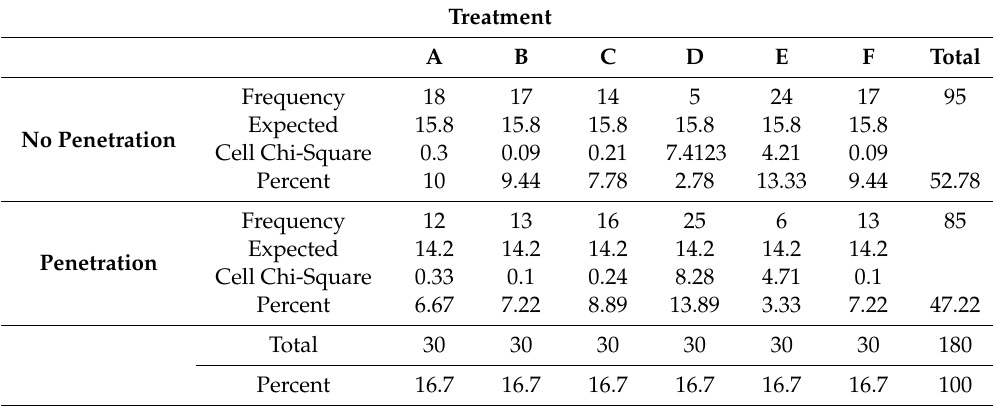
Table 2. Penetration of the dye beneath the dental sealant showing di ff erences between the groups in the numbers of teeth with and without penetration. Penetration was compared between the groups using Fisher’s exact